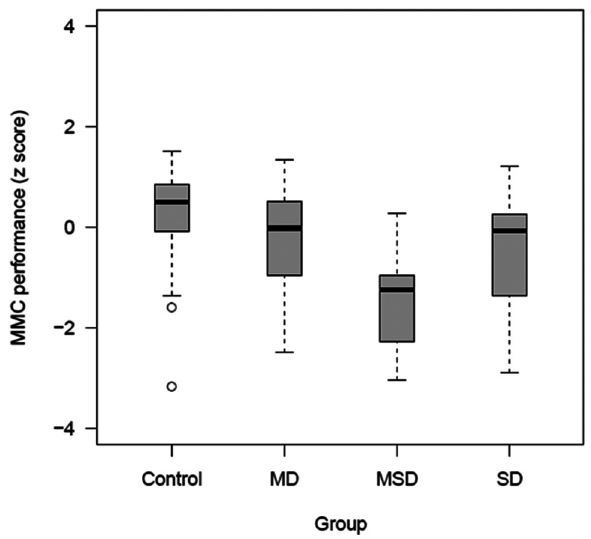
Figure 1. Performance of school achievement groups on